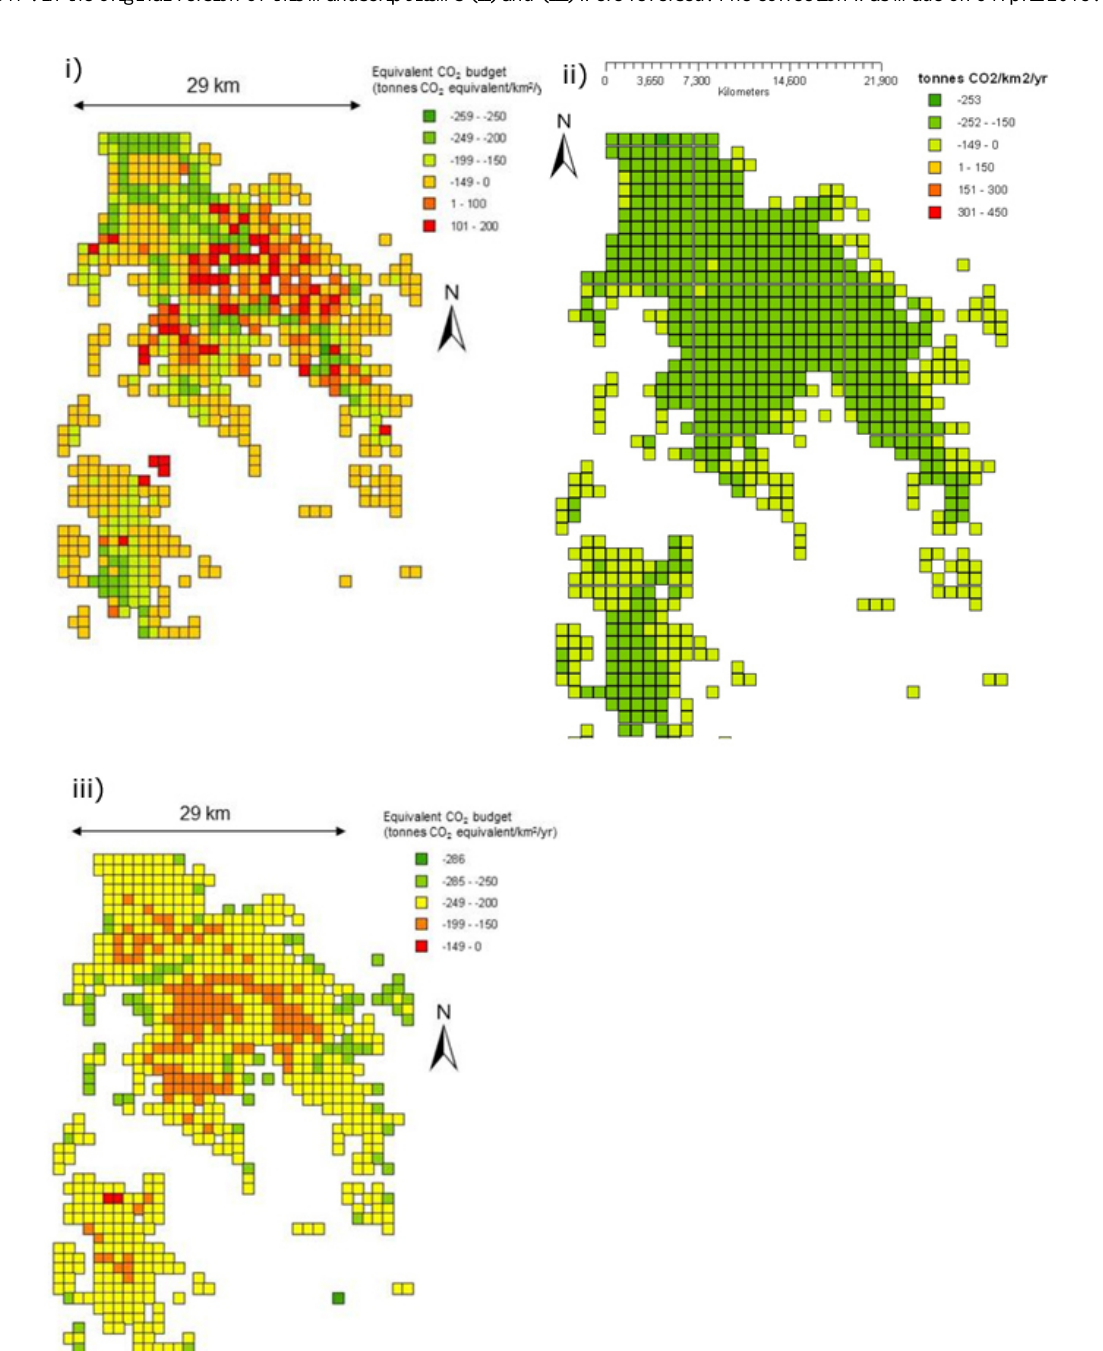
Fig. 5 . Carbon budget in Peak District National Park showing (i) current carbon budget (-62 tonnes CO eq/km²/yr); (ii) carbon budget in 2 2030 under active management for carbon, including various combinations of cessation of grazing and burning, blocking drainage ditches and gullies, and revegetation of bare and eroding peat soils (-160 tonnes CO eq/km²/yr); and (iii) carbon budget in 2030 with cessation of 2 grazing and burning (-117 tonnes CO eq/km²/yr) 2 ERRATUM: In the original version of this manuscript items (ii) and (iii) were reversed. The correction was made on 9 April